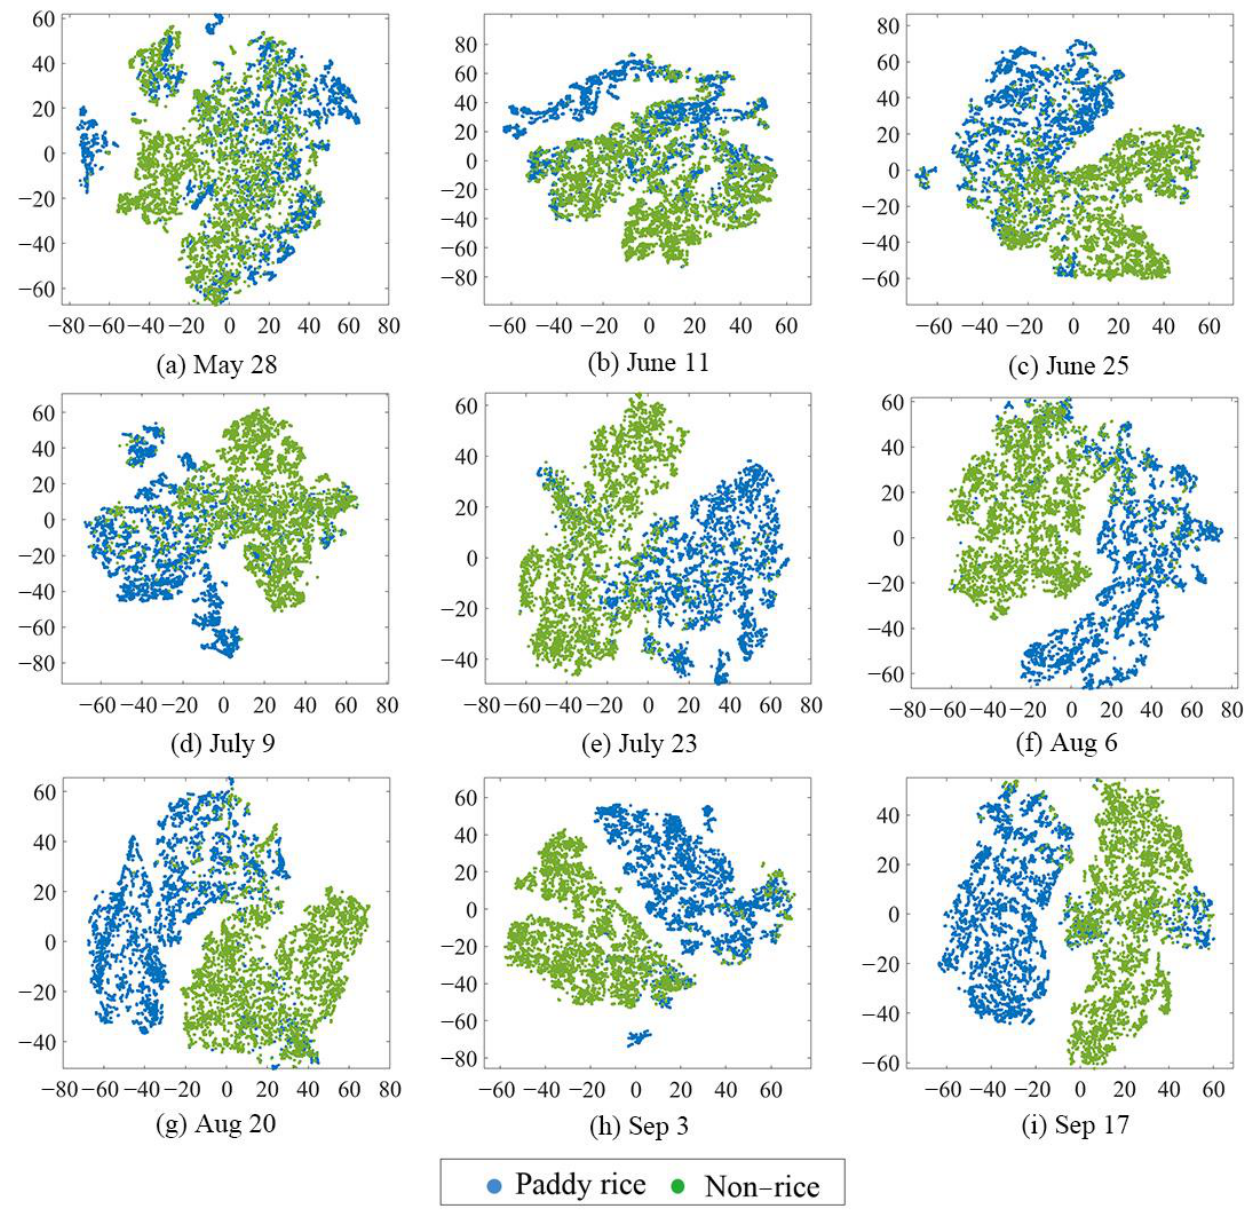
Figure 13. Visualization of features extracted on different mapping date as the length of the time series increasing, which started from 16 April 2020.